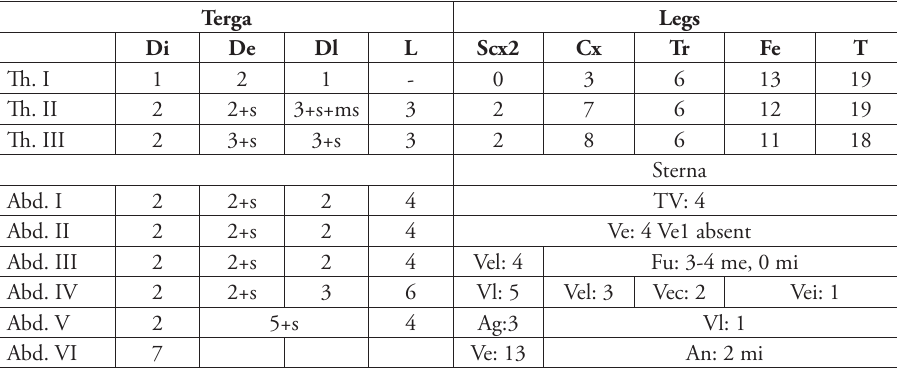
Table 2c. Chaetotaxy of Lobellina pomorskii sp. n.: postcephalic chaetotaxy. Terga Legs